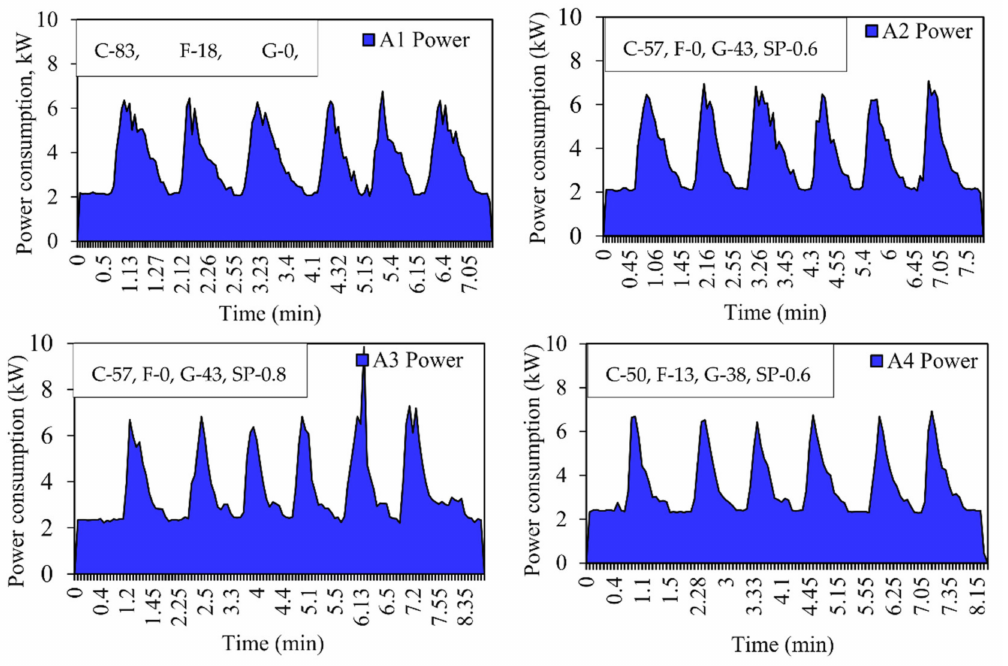
Figure 5. Energy consumption curve for M25 grade concrete for Mix A1, A2, A3, and A4. C—Cement, F—Fly ash, G—GGBS, SP—Superplasticizer, (expressed in %).